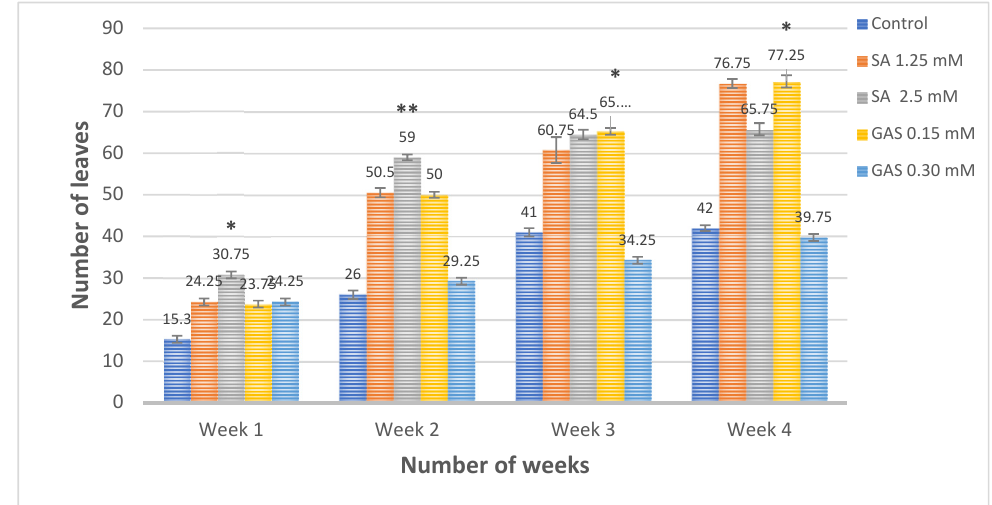
Figure 9. The average number of leaves in infected tissue cultured potato plantlets Solanum tuberosum L. selena with PLRV in response to salicylic acid (1.25 and 2.5 mM) and Glycyrrhizic Acid ammonium salt (0.15 and 0.30 mM) nanoparticles compared to positive control after two weeks. Two-way ANOVA was used to analyze the data. * p < 0.05, ** p < 0.01 show significant variations in the number of shoots.